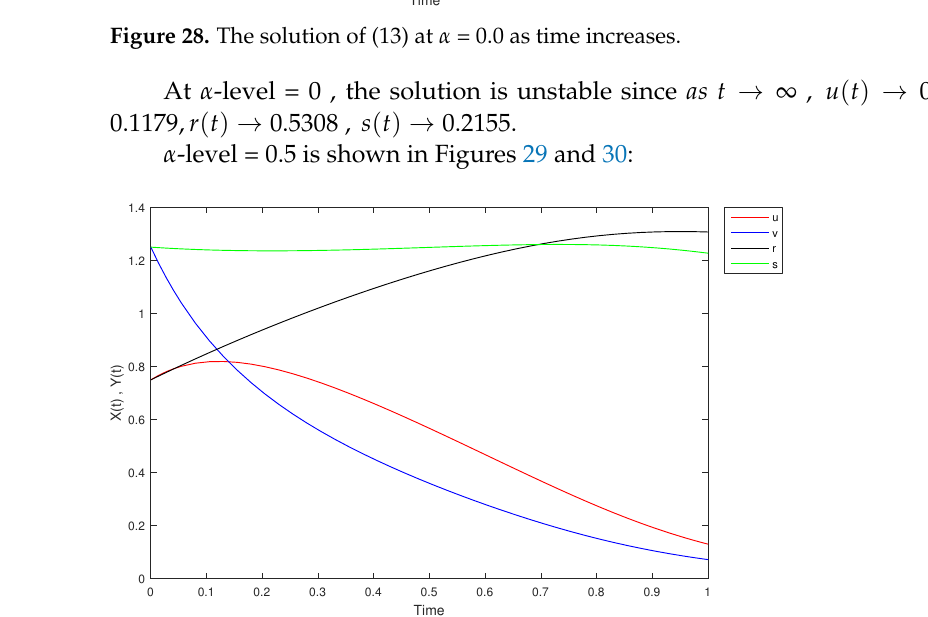
Figure 29. The solution of (13) at α = 0.5 for a short time period.